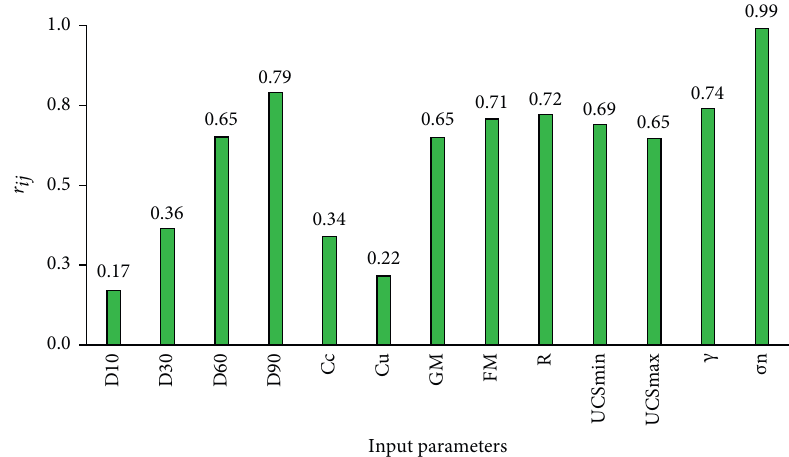
Figure 7: Sensitivity analysis